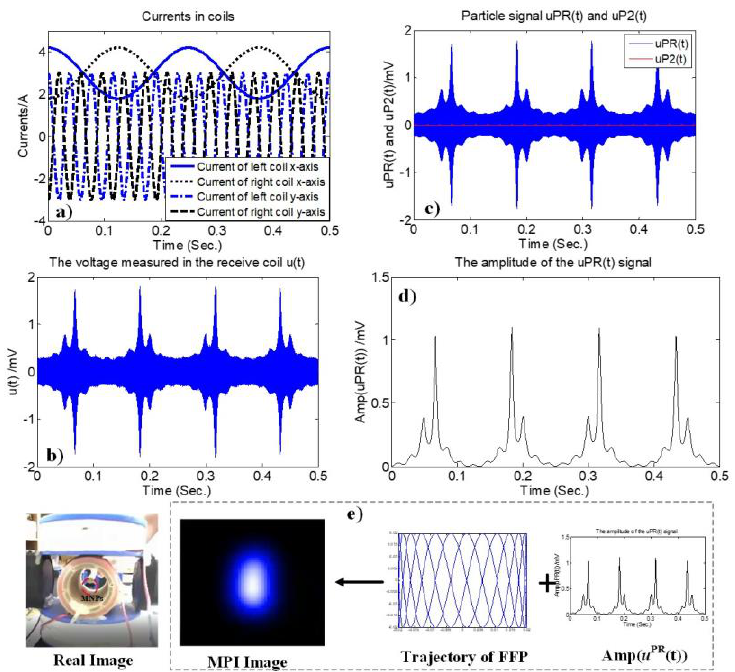
Figure 5. Two-dimensional amplitude-modulation (AM) MPI signal results for MNPs at the center of workspace with the following parameters: t MPI = 0. 5 s, I DC = 3 A, I ACx = 1.2 A, f x = 4 Hz, I ACy = 3 A, f y = 26 Hz; ( a ) waveforms of the currents in the DCCs in Equation (8). ( b ) Voltage measured in the receive coil u ( t ), ( c ) u PR ( t ) and minor-component u P 2 ( t ) in Equation (20) after noise removal by a band-pass filter, ( d ) amplitude of u PR ( t ) after the analysis phase, and ( e ) real and MPI images of MNPs at the center of